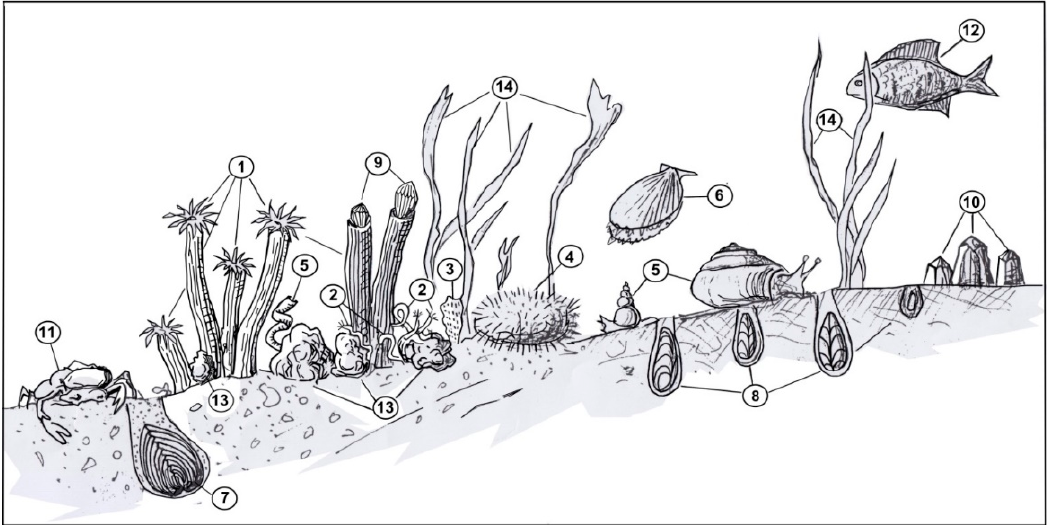
Figure 7. Paleoecological reconstructions of the Early Gelasian (Pleshet stage) marine benthic association of the Evron quarry in northern Galilee (northern Israel) (this figure is composed using the personal experience of the authors). (1) Scleractinian corals ( Cladocora sp. ), (2) Polychaeta worms (Serpula, Spirorbis), (3) Bryozoa, (4) Echinoidea, (5) Gastropod mollusks ( Vermetus, Natica and oth.), (6)–(8) Bivalvian mollusks: (6) Pectinidae, (7) Cardiiidae, (8) Lithophaga , (9)–(11): Arthropods: (9) Creusia , (10) Balanus , (11) Crabs, (12) Fishes, (13)–(14) marine Plants: (13) Lithotamnion biogenic carbonates, (14) thalloid Chlorophycea.